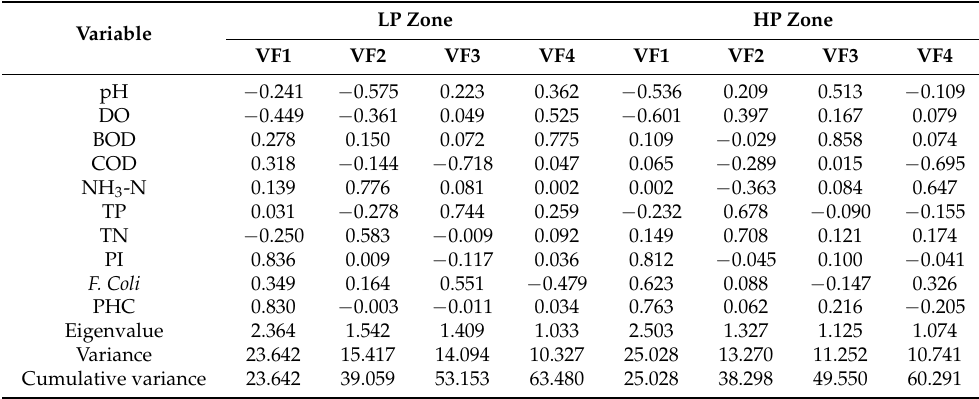
Table 2. Loadings, eigenvalue, percentage of variance, cumulative percentage variance of ten selected variables on varimax rotated factors in low pollution (LP) and high pollution (HP)